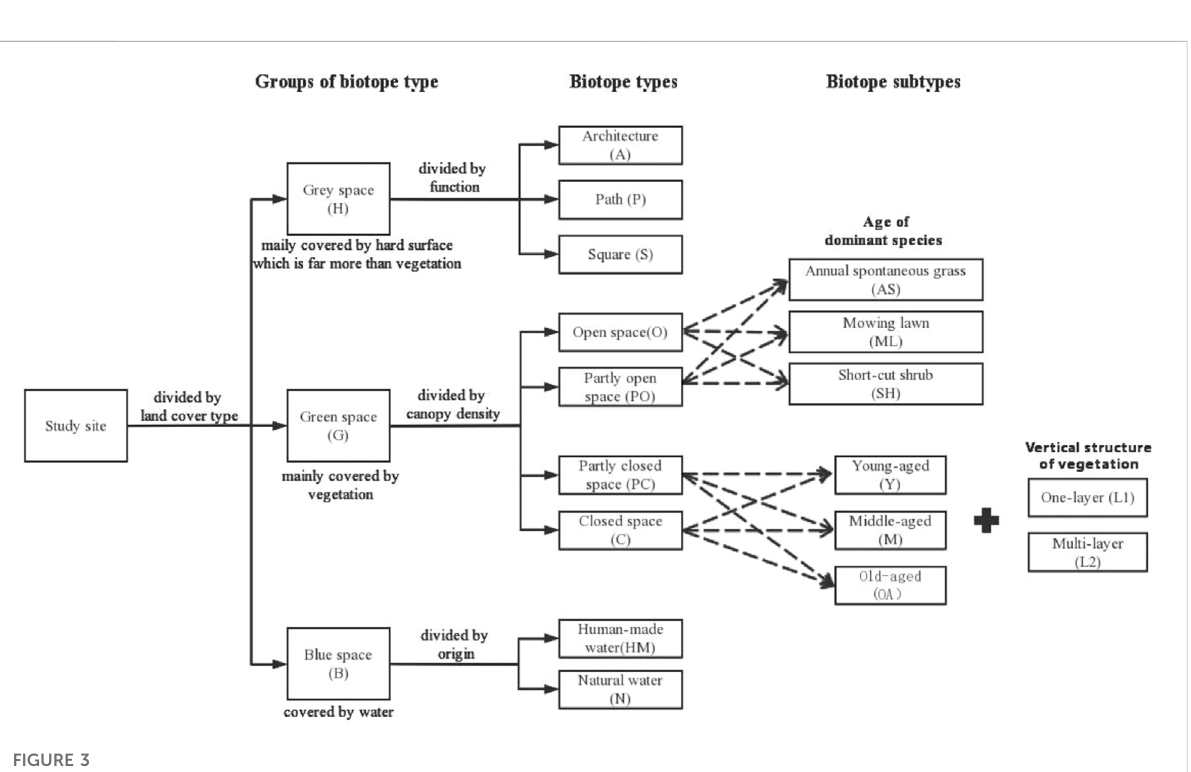
resolution of 0.5 m) and the 1:1,000 topographic map of the study area. The data were stored, edited and analyzed, with the support